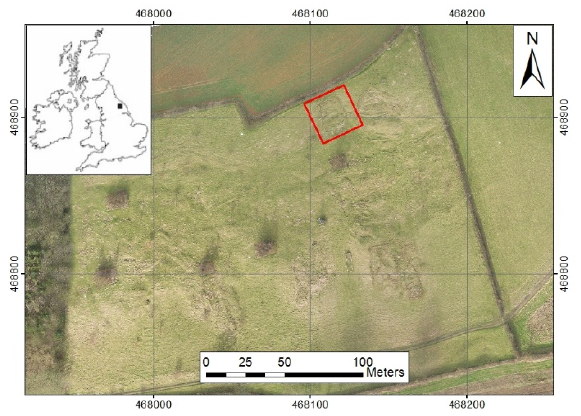
Figure 1. Overview of test site located at Hollin Hill landslide observatory: the red boxed area is used for this